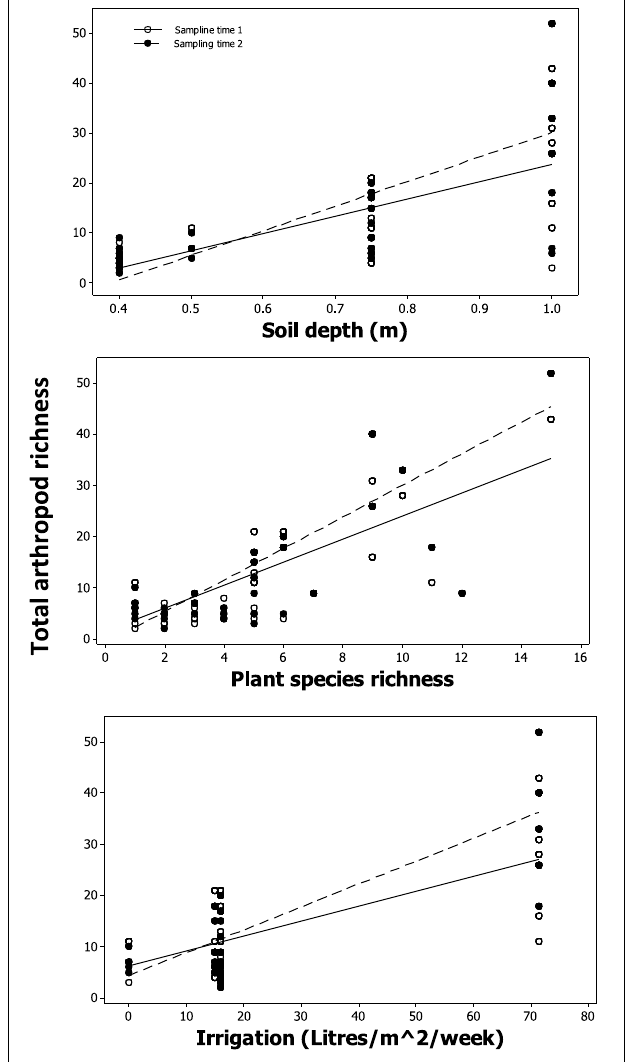
FIGURE 6 | Modeled relationship between total arthropod richness, soil depth, plant species richness, and irrigation